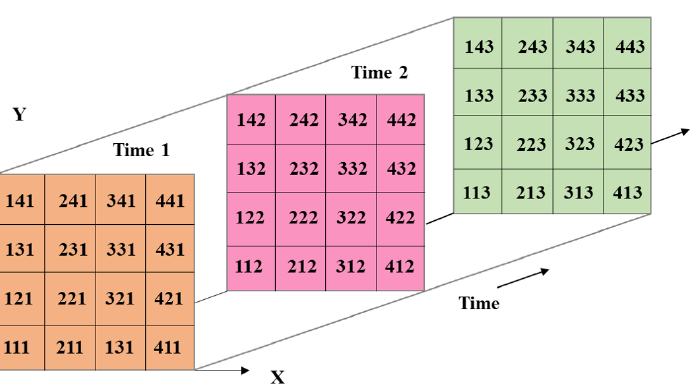
Figure 3. Schematic diagram of the temporal and spatial representation of the monitoring